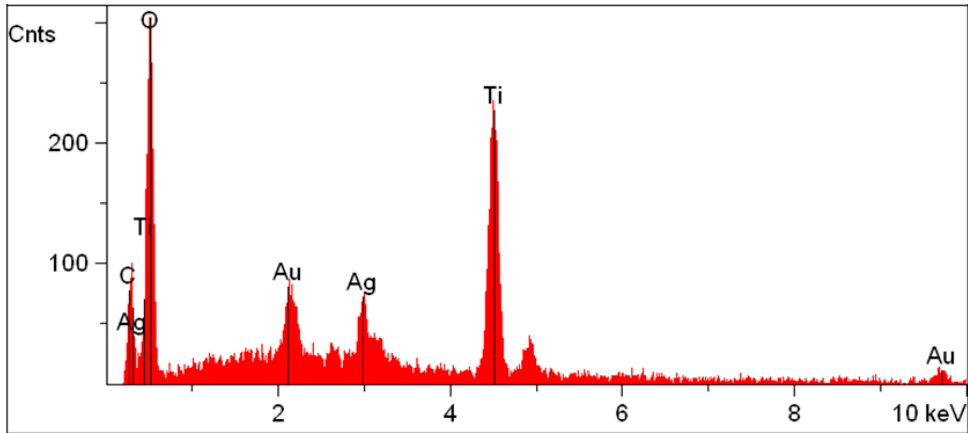
Figure 5. EDS analysis of Ag/TiO 2 /cellulose composite film doped with 5 mol % of Ag. The XRD patterns of cellulose, TiO 2 /cellulose, and Ag/TiO 2 /cellulose composite films and TiO 2